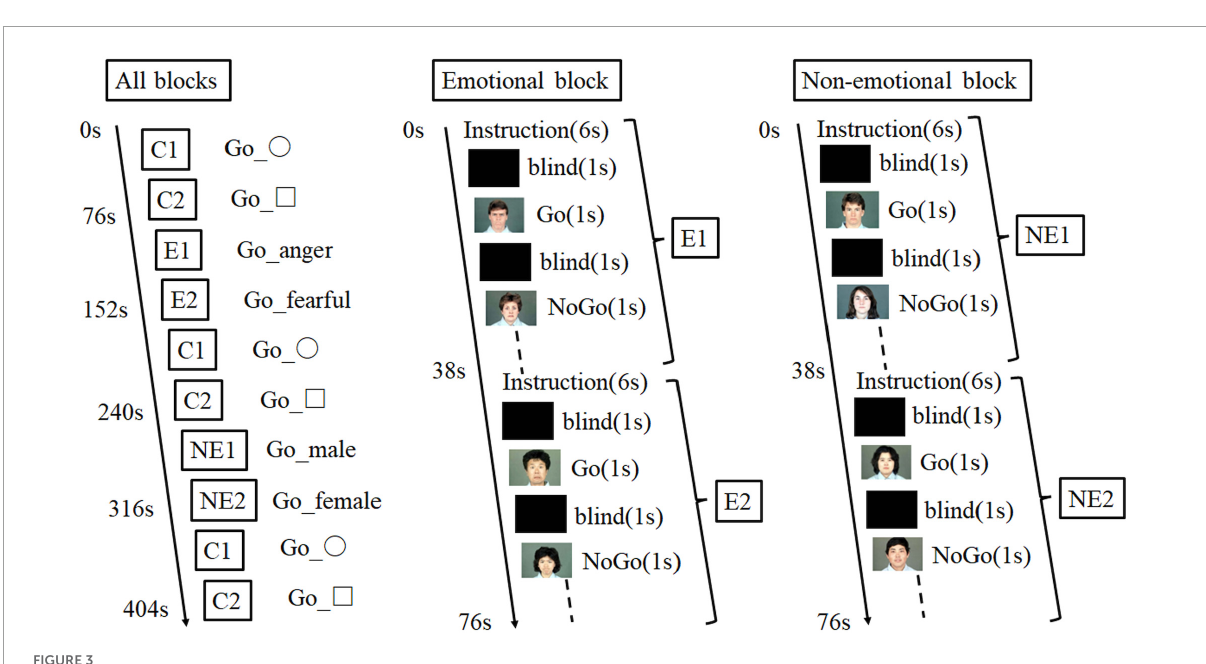
FIGURE3 Experimental design of the emotional go/no-go